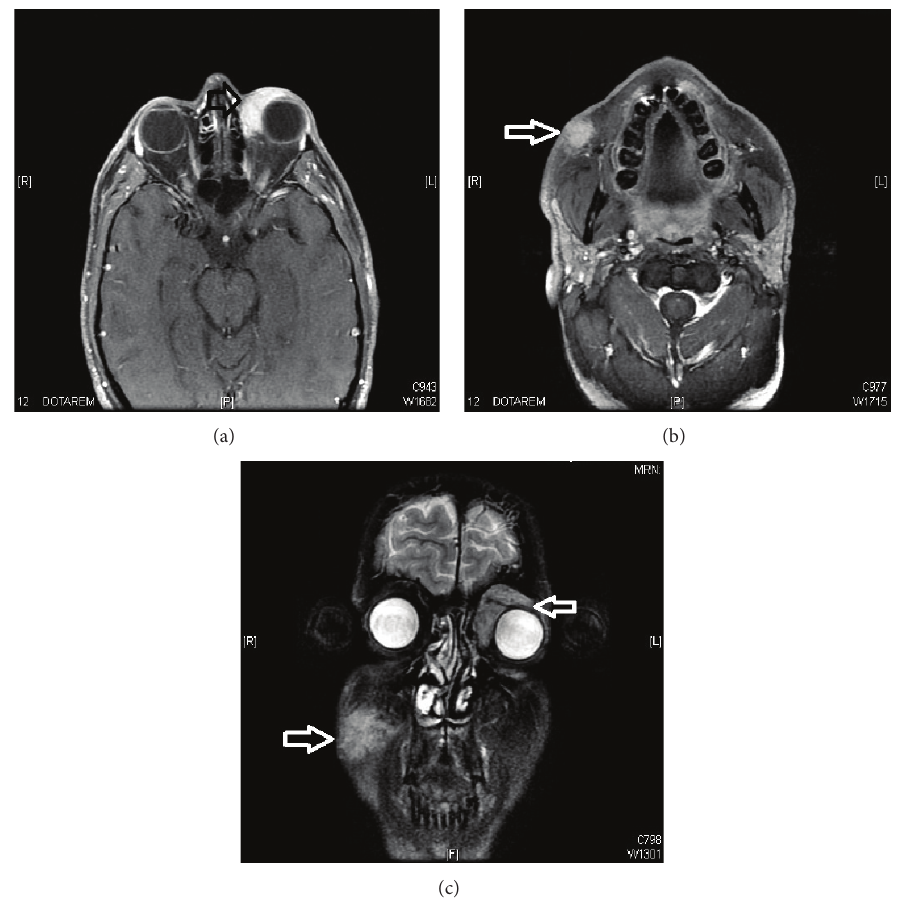
Figure4:Magneticresonanceimaging(MRI)((a)and(b))axialand(c)coronalimagesofheadshowingrecurrentmasstissuelesioninvolving theleft eyelid, mainly superiorlyand medially progressingdeeply to surroundthesuperiorand medial recti muscles as well as superioroblique musclemainlyattheirinsertionontheocularglobeandanothermasstissuelesioninvolvingtherightcheekincludedwithinthesubcutaneous tissue showing intense enhancement measuring about 3 × 2 cm without obvious deep